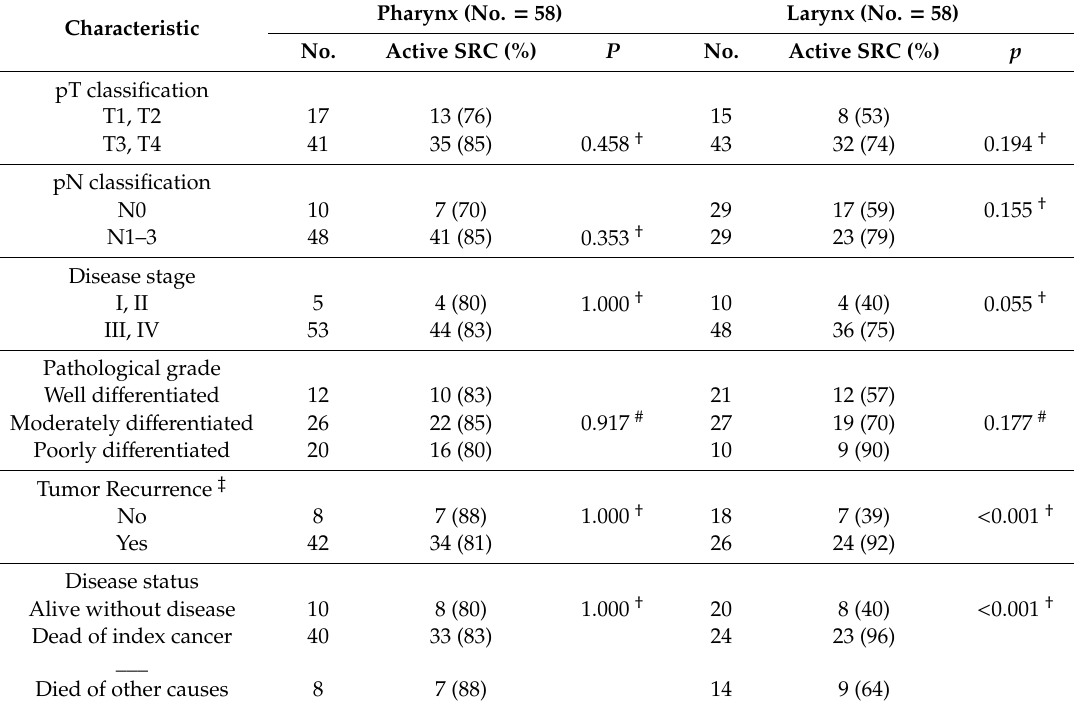
Table 2. Associations of active SRC expression with clinical and follow-up data for patients with pharyngeal and laryngeal